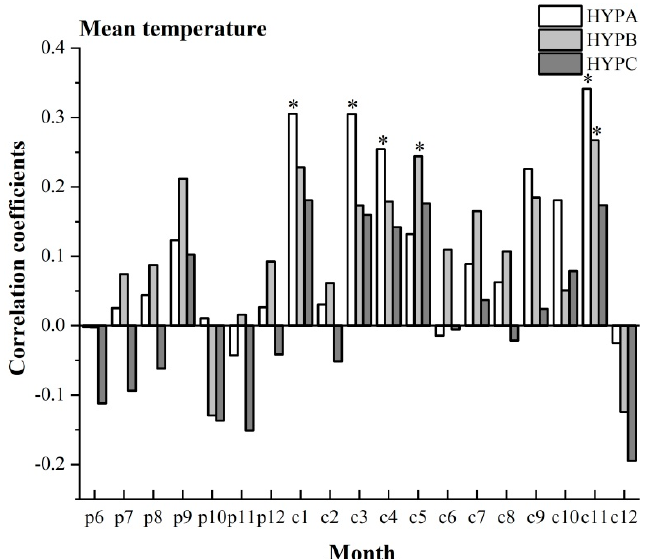
Figure 6. Correlations between the chronology of L. principis-rupprechtii tree rings and the monthly mean temperature at different elevations ( p represents the previous year; c represents the current year; and the * symbol represents a significant correlation at the 0.05 level).